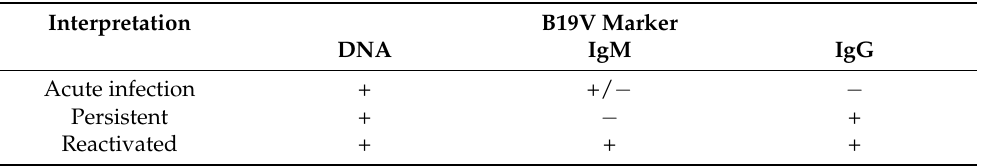
Table 1. Interpretation of human parvovirus (B19V) serological patterns in immunocompetent individuals.